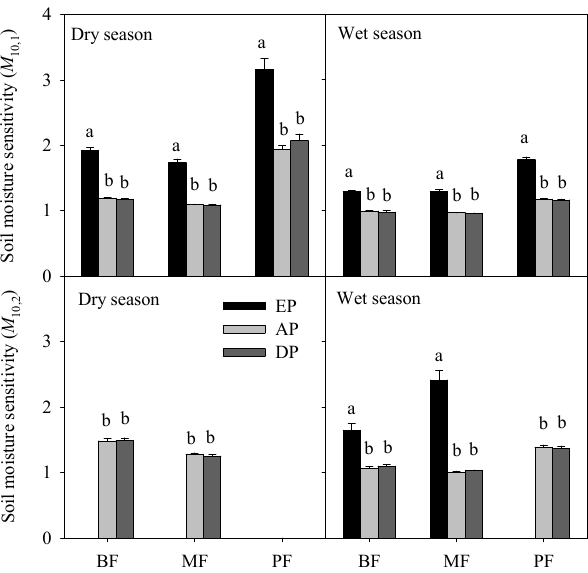
Fig. 3. Moisture sensitivities of soil respiration ( M 10 , 1 and M 10 , 2 ) in Eq. (2) under different seasons and different precipitation treat- ments at the DNR forests. The treatments are as follows: precipita- tion exclusion (EP), ambient precipitation (AP), and double precipi- tation (DP). The forests are as follows: broadleaf forest (BF), mixed forest (MF), and pine forest (PF). Error bars are standard errors. Eq. (2) and its coefficients are listed in Table 5. Several M 10 , 2 val- ues were not calculated because some of soil moisture in the plots is less than 10%vol.